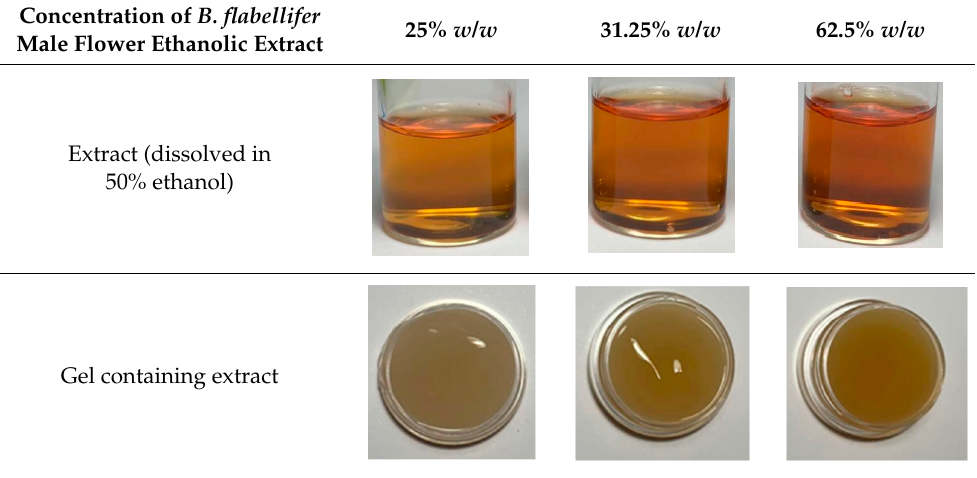
Table 3. Appearance of B. flabellifer male flower ethanolic extract and gel containing 25, 31.25, and 62.5 % w/w B. flabellifer male flower extract.